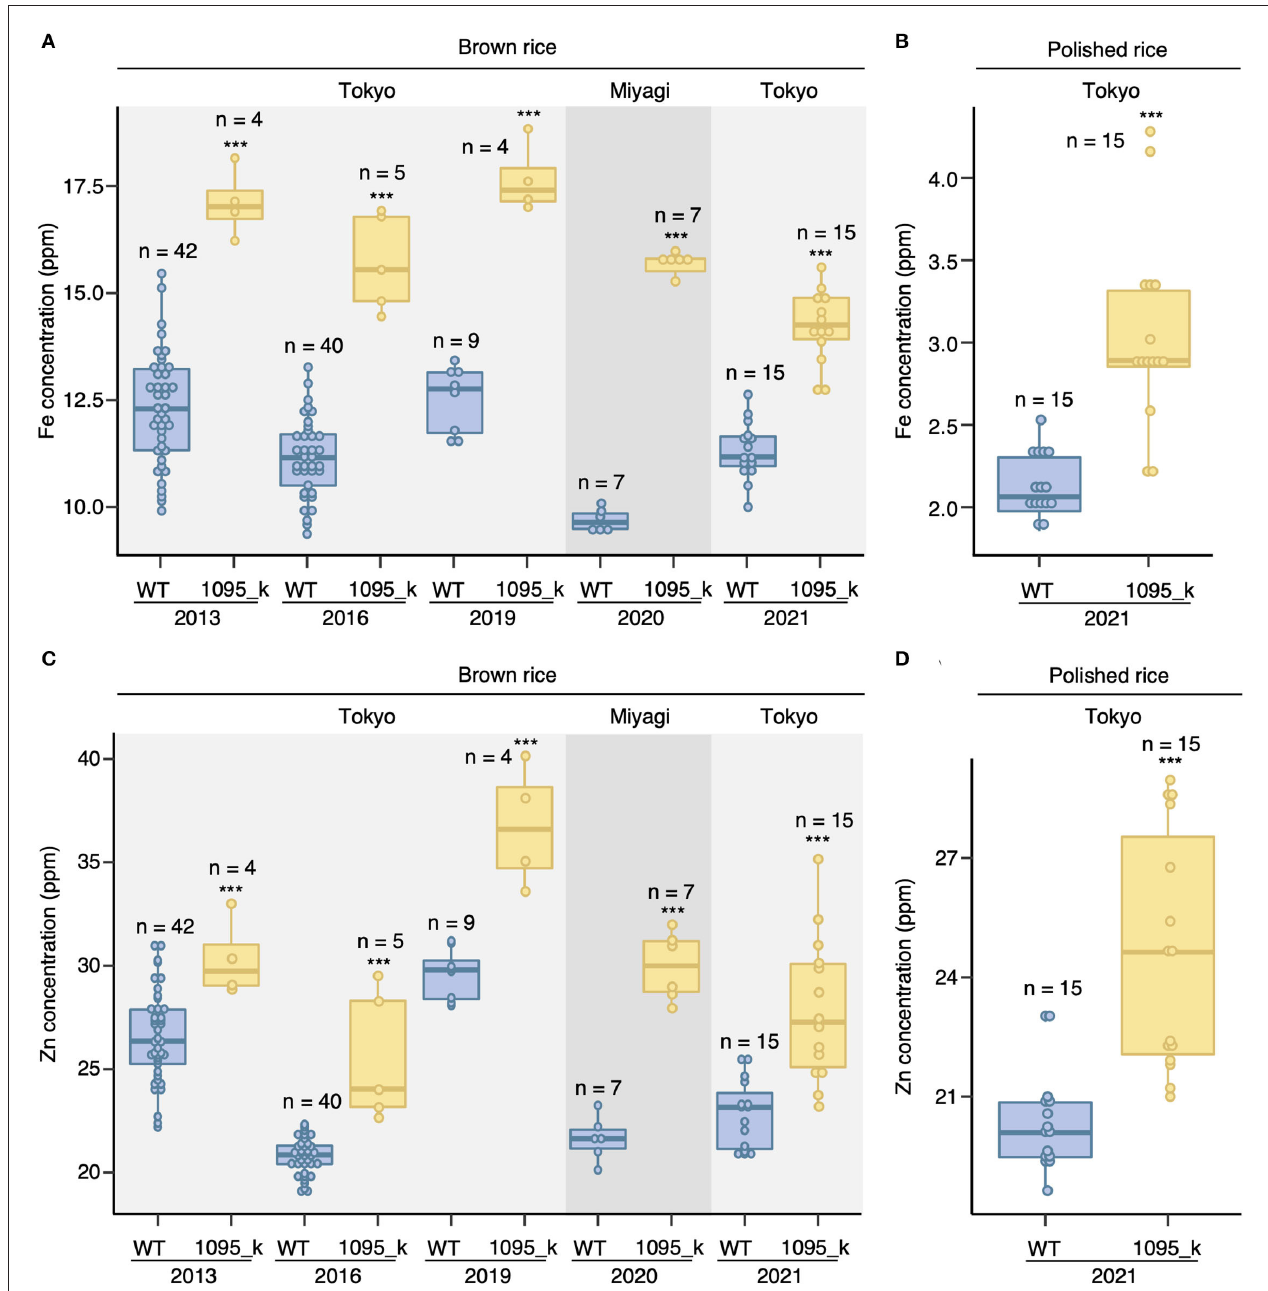
FIGURE 1 | Brown rice Fe and Zn concentration. (A) Fe concentration in brown rice, (B) Fe concentration in polished rice, (C) Zn concentration in brown rice, and (D) Zn concentration in polished rice of wild type (WT) Hitomebore and mutant (1095_k). Plants were cultivated in 5 independent years on the paddy field of the Institute of Sustainable Agro-ecosystem Services, The University of Tokyo, in Tokyo, and on the field of Tohoku University in Miyagi. The number of replicates is shown in figure. Significant differences were calculated using Student’s t -test. *** p < 0.001.